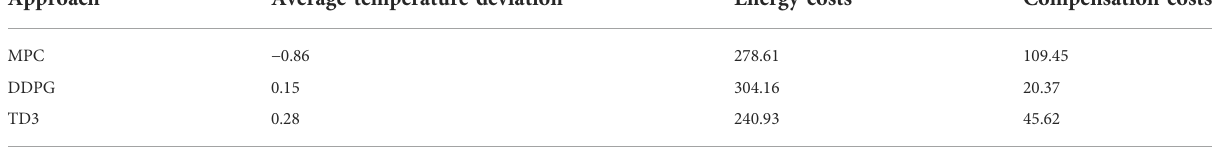
TABLE 3 Simulation